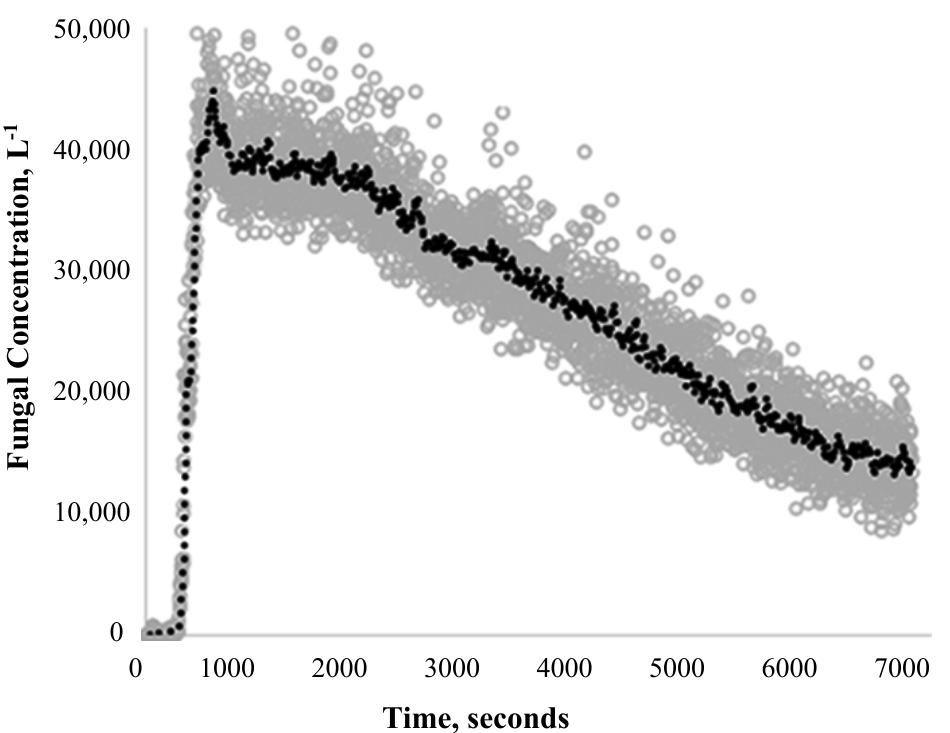
Figure 8. Natural settlement of A. niger fungal aerosol in the rotating aerosol chamber (raw data is shown in grey, and the trendline is presented in black).